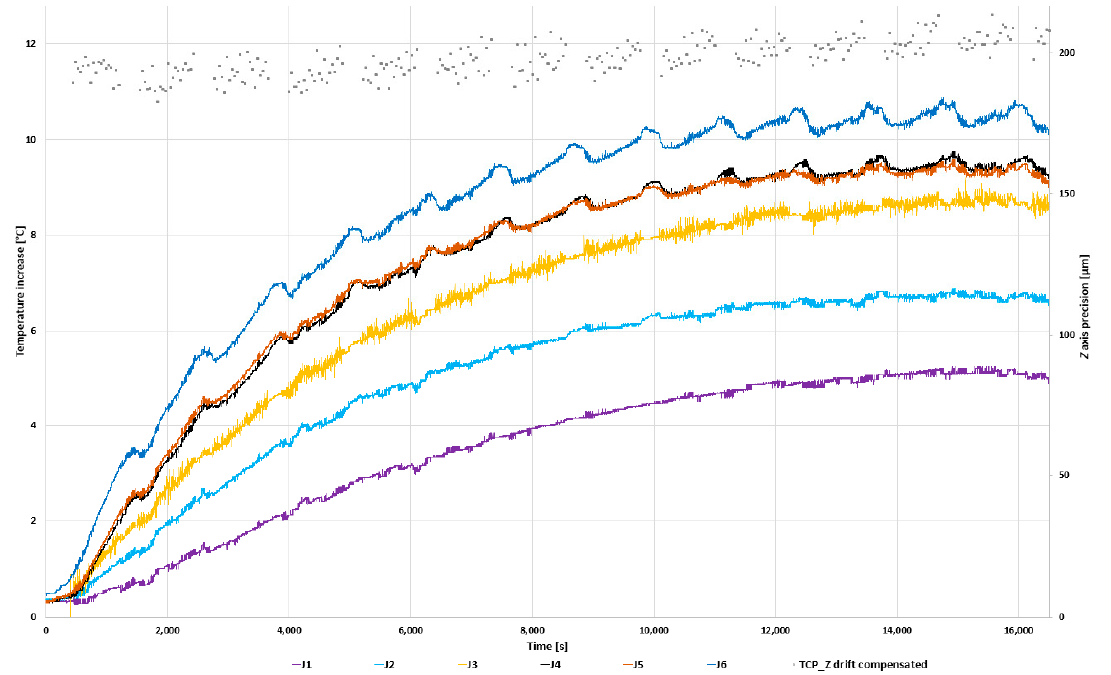
Figure 11. Target 5, working speed, compensated TCP Z Drift, measurement with interrupts. Data recorded during the initial measurement: purple—joint 1 temperature, light blue—joint 2 temperature, yellow—joint 3 temperature, black—joint 4 temperature, orange—joint 5 temperature, dark blue—joint 6 temperature, grey trend represents the TCP Z drift with drift compensation applied on measurement that was systematically disrupted.